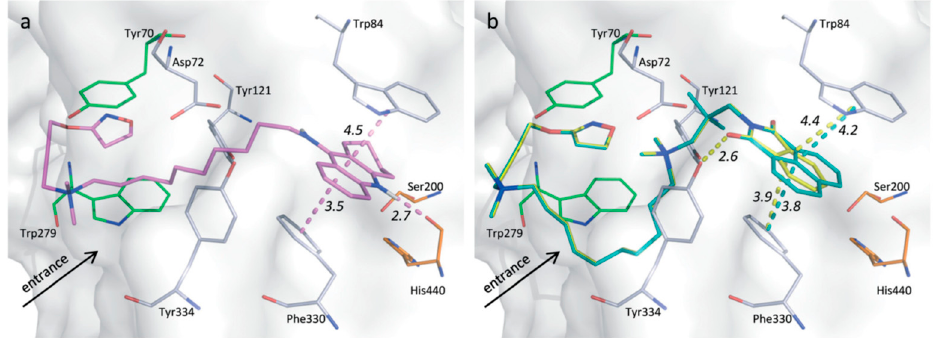
Figure 23. ( a ) Docking pose of 45-C10 (pink), with the interaction distances shown in the CAS (orange) and in the PAS (green). ( b ) Docking representation of 5b-C10 (blue) and 5a-C10 with their interaction distances shown in yellow. Reproduced with permission from [110].